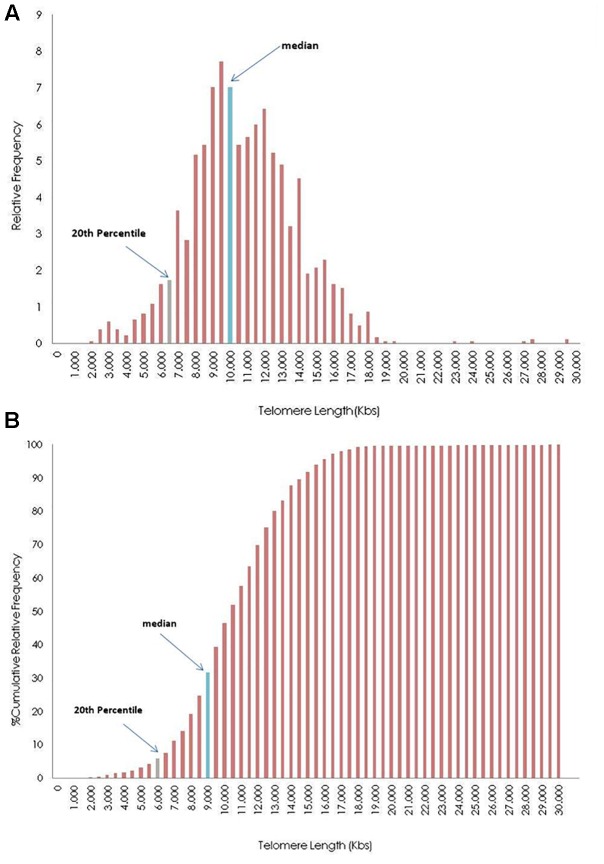
Distribution of telomere length (TL) in 0.5 kilobases (Kb) intervals of the whole genome frequencies (A) and cumulative frequencies (B) of a participant. The blue bar represents the group where the median values of the TL is in frequencies bar, and gray bar shows the group where the median of 20th percentile of telomeres (upper limit of short telomeres) is located.